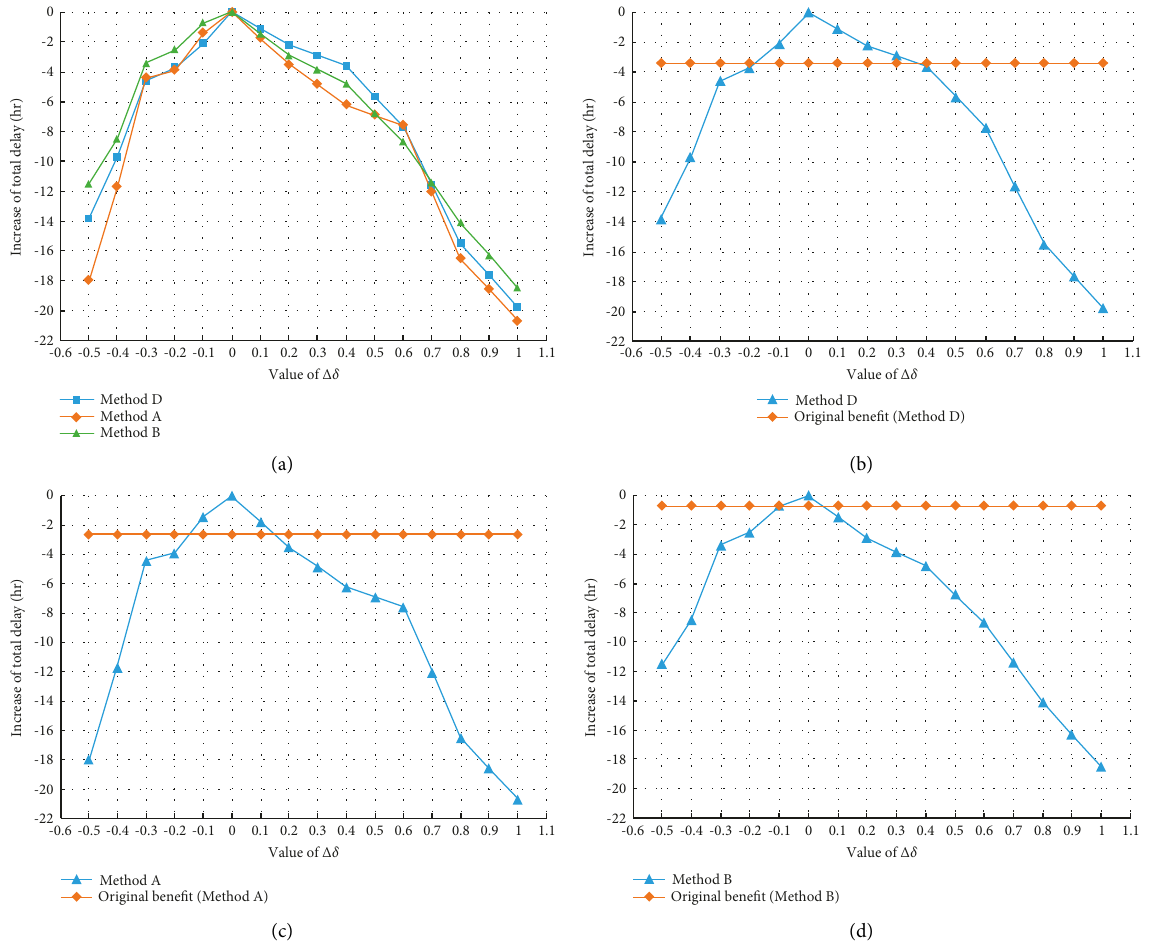
Figure 10: The control benefit change trend chart of each control